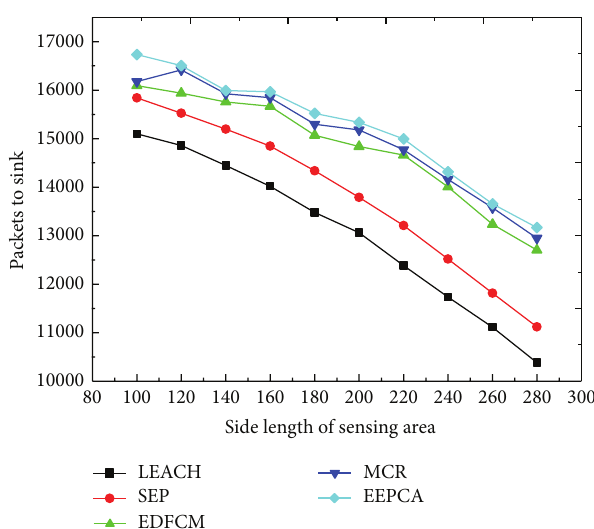
Figure 5: Packets to sink with varying side length of sensing